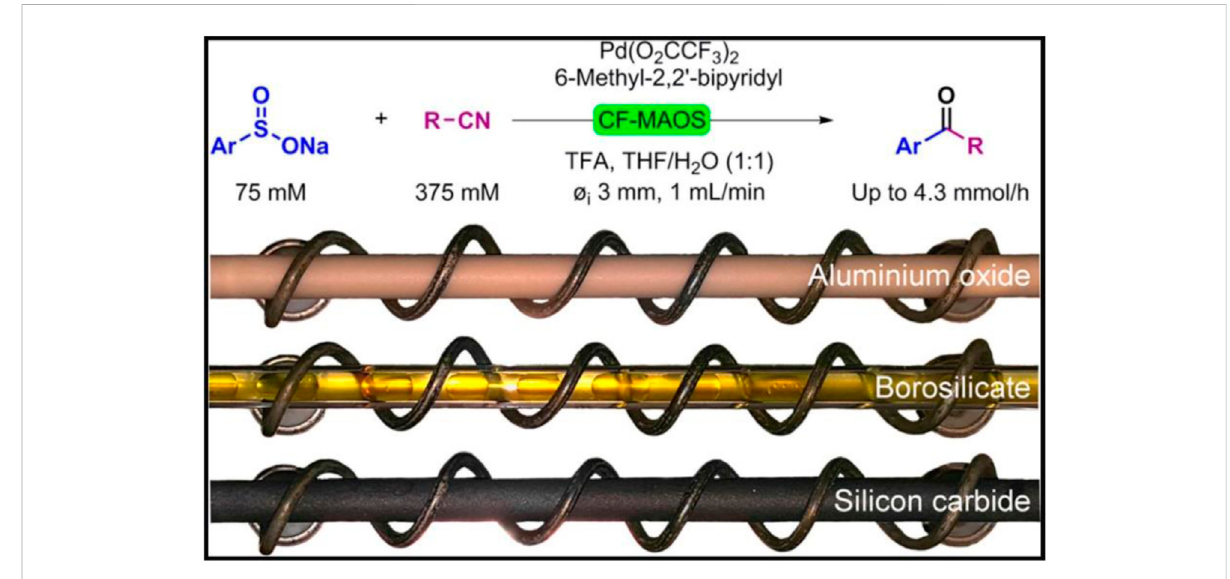
FIGURE 8 MW-assistedcontinuous fl owPalladium(II)-catalyzeddesul fi tativesynthesisofarylketones.Reprintedwithpermissionfrom(Skillinghaugetal., 2016). Copyright (2016) American Chemical Society.